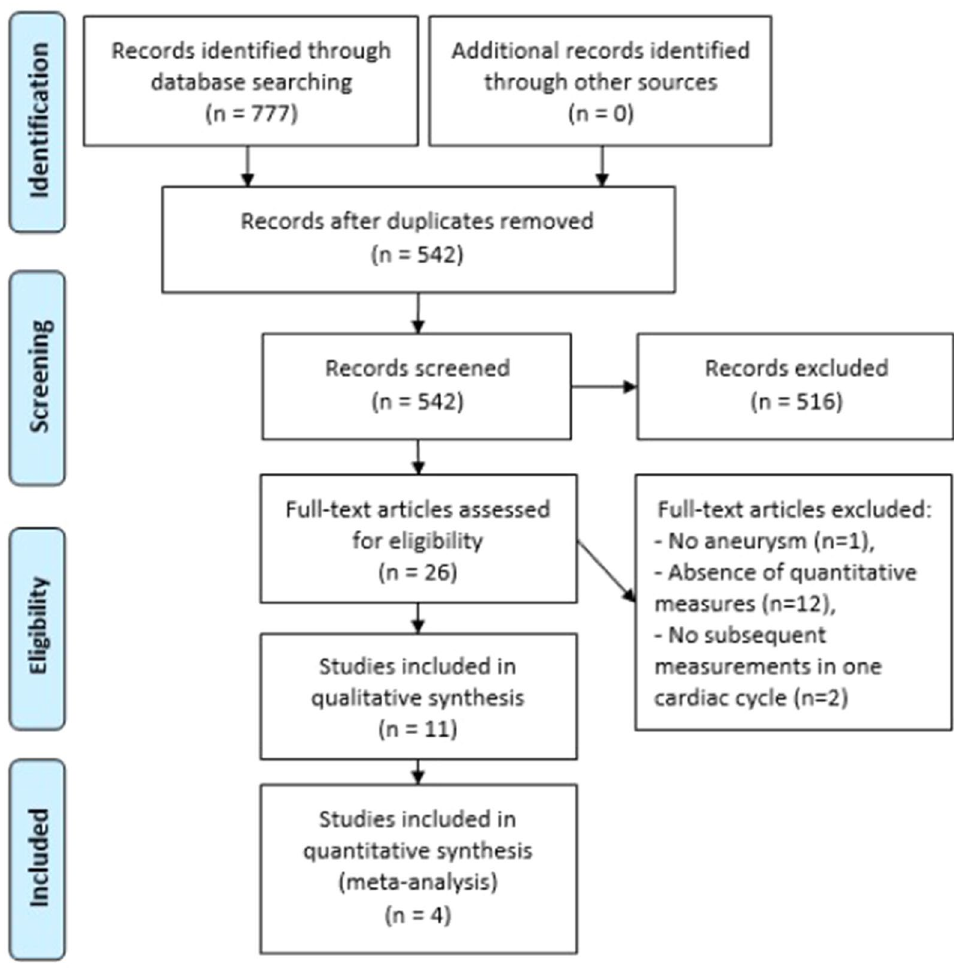
Figure 1. Prisma flow chart of the included studies 27